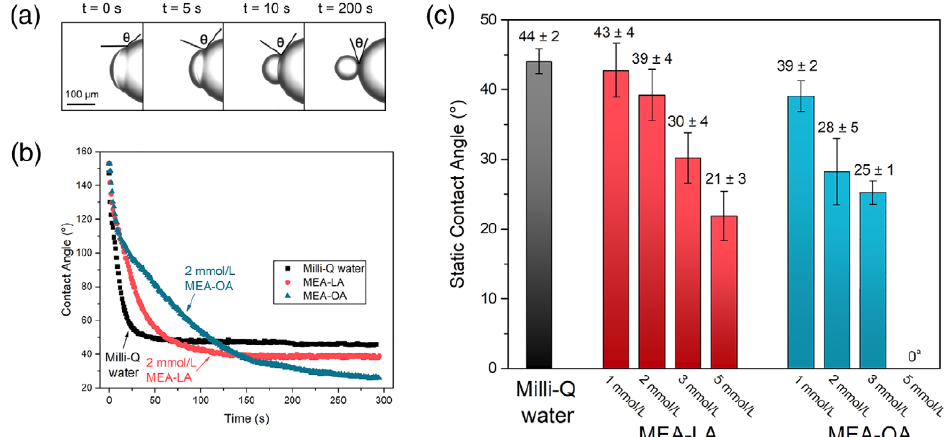
Figure 19. ( a ) Snapshots of a high viscosity oil droplet receding on a silica surface in Milli-Q water; ( b ) Dynamic contact angle in the first 300 s; and ( c ) Static contact angles in different aqueous solutions. a The oil drop detached from the silica surface in 5 mmol/L MEA-OA solution, thus showing as a contact angle of zero degree. Reprinted with permission from Ref. [25]. Copyrights 2021, copyright Wiley. More details on Copyright and Liscensing are available via the following link: https://aiche.onlinelibrary.wiley.com/